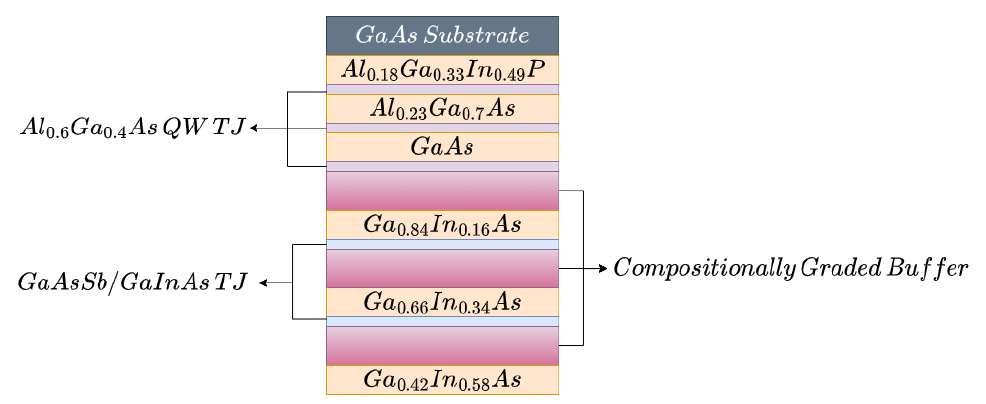
Figure 1. Depiction of the multi-junction